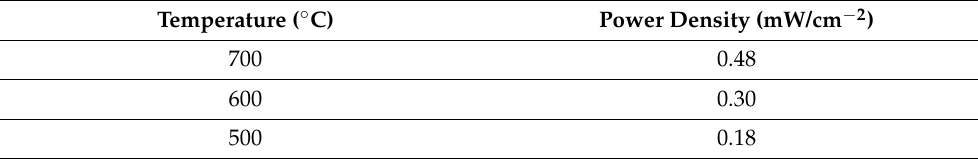
Table 5. Power density value of single cell at 500–700 ◦